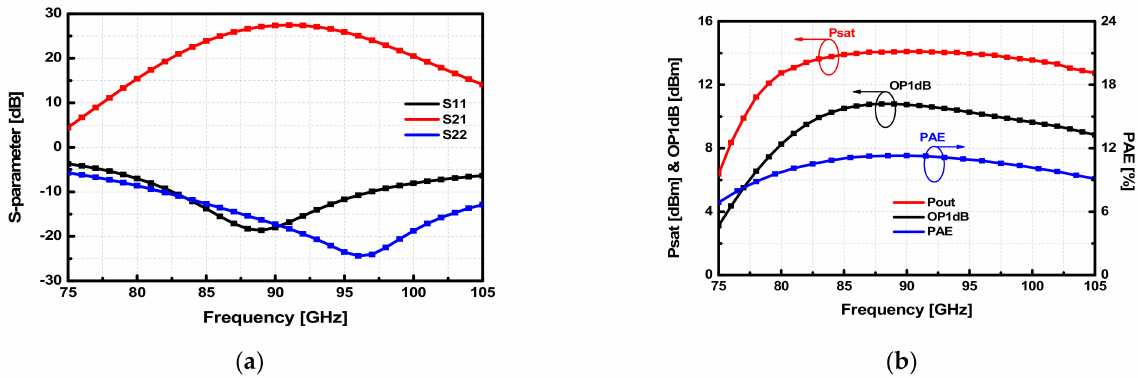
Figure 7. Simulation results of ( a ) S-parameters and ( b ) large signals of the W-band 4-way PAs.